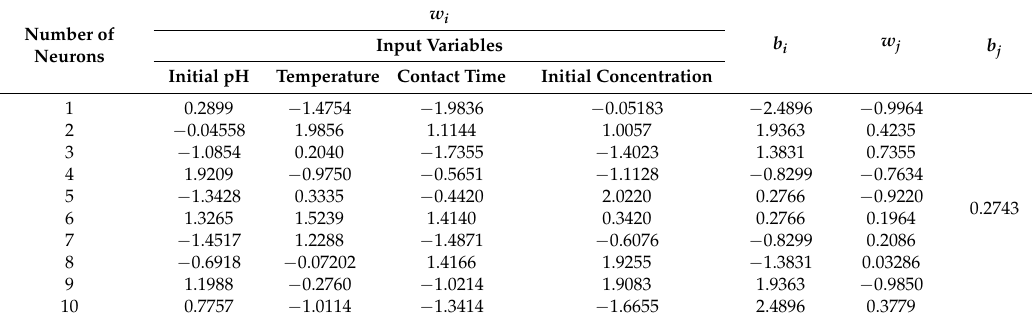
Figure 14. The MSE of the number of epochs. Table 4. The weights and biases of BP-ANN in input-hidden layer ( w i and b i ) and hidden-output layer ( w j and b j ).